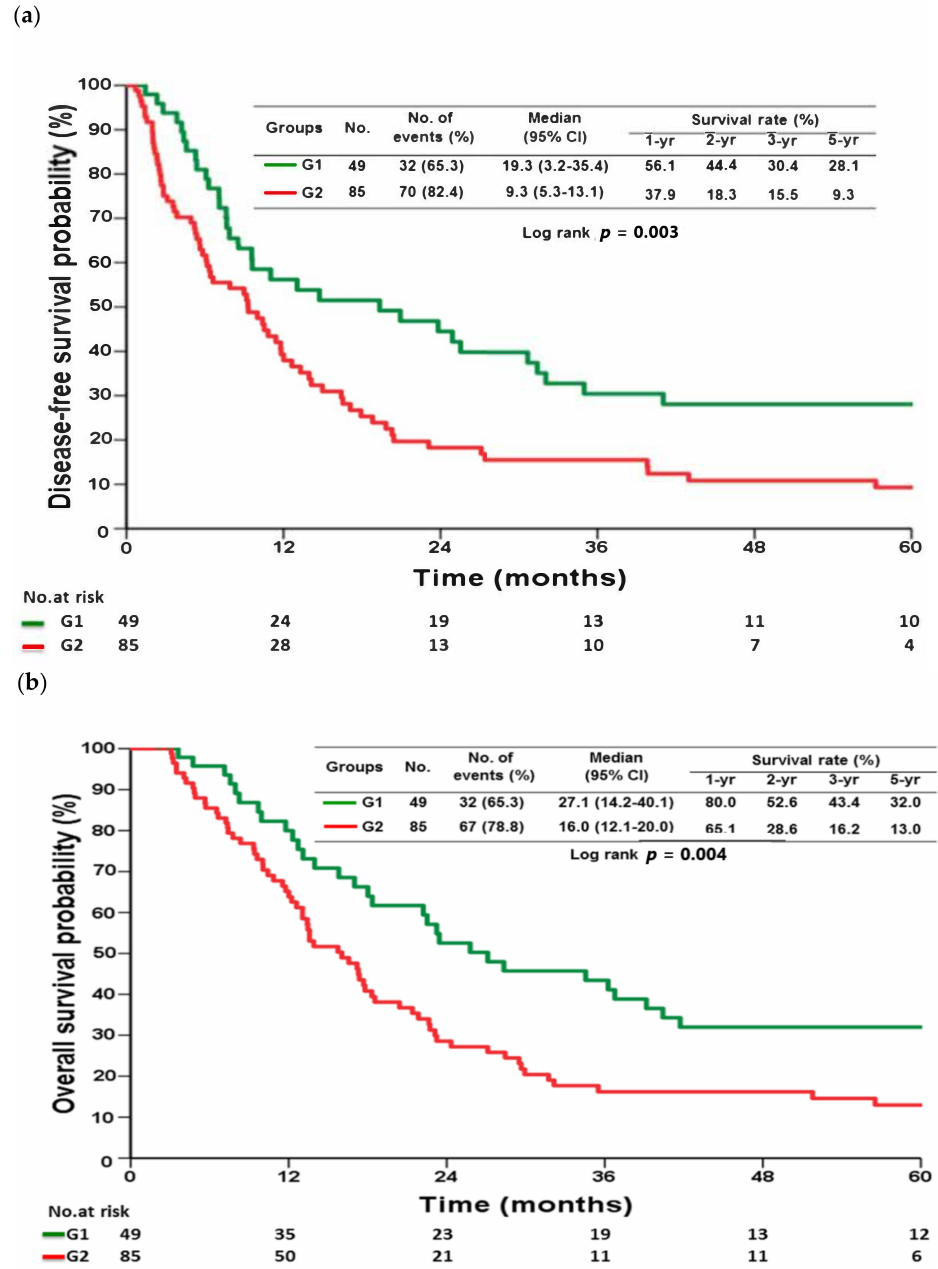
Figure 1. Disease-free survival ( a ) and overall survival ( b ) between G1 and G2 patients.